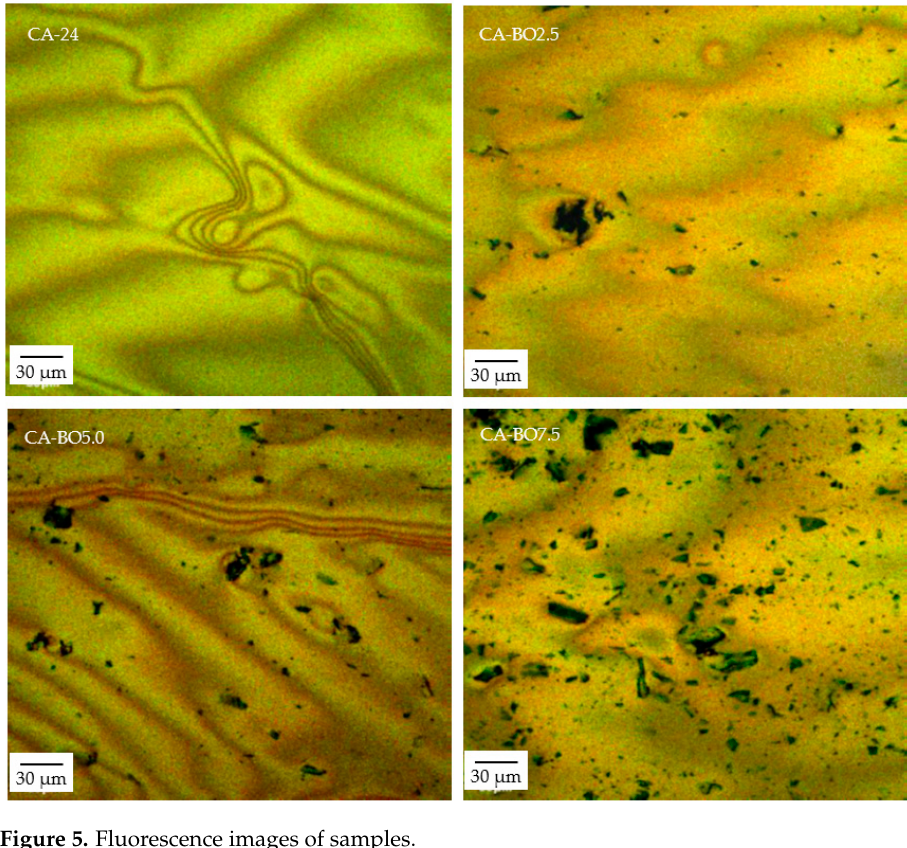
Figure 5. Fluorescence images of samples.